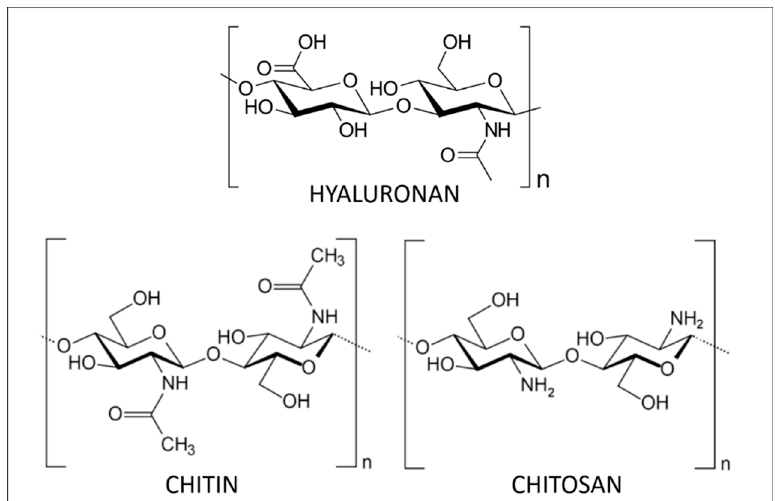
Figure 1. Chemical structure of marine polysaccharides: HA, chitin and chitosan.